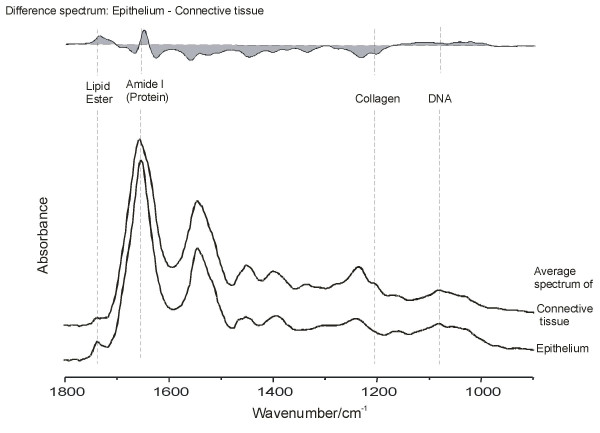
Comparison of the mean infrared absorption spectra* of epithelial (lower spectrum) and connective tissue (upper spectrum) and the epithelial-connective tissue difference spectrum. *Spectra are baseline corrected.